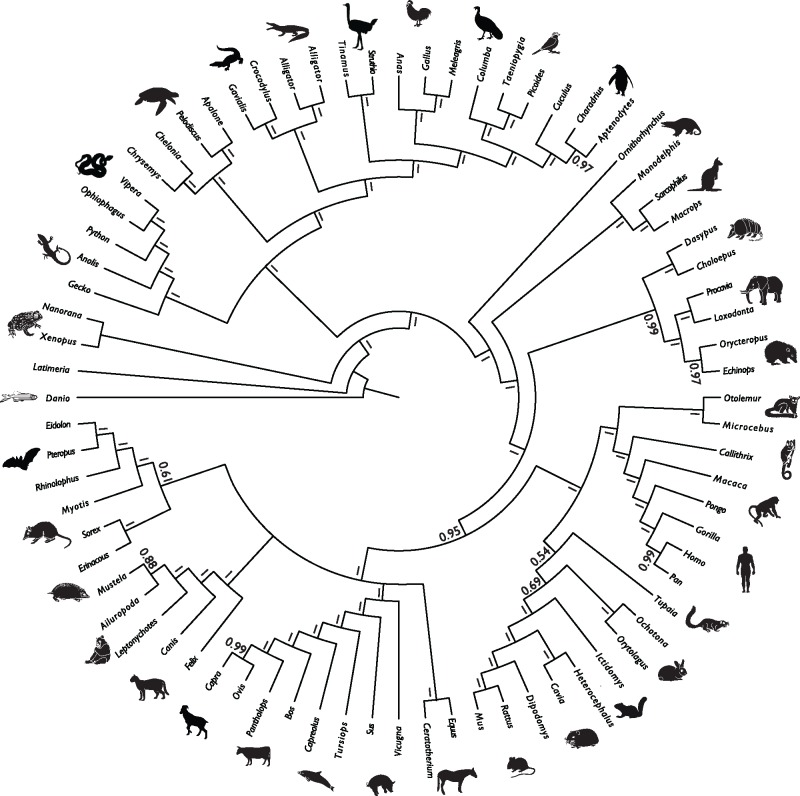
—Phylogenetic tree derived from phylogenetic analysis of the concatenated analysis of pri-miRNA sequences. Node values are clade posterior probabilities.